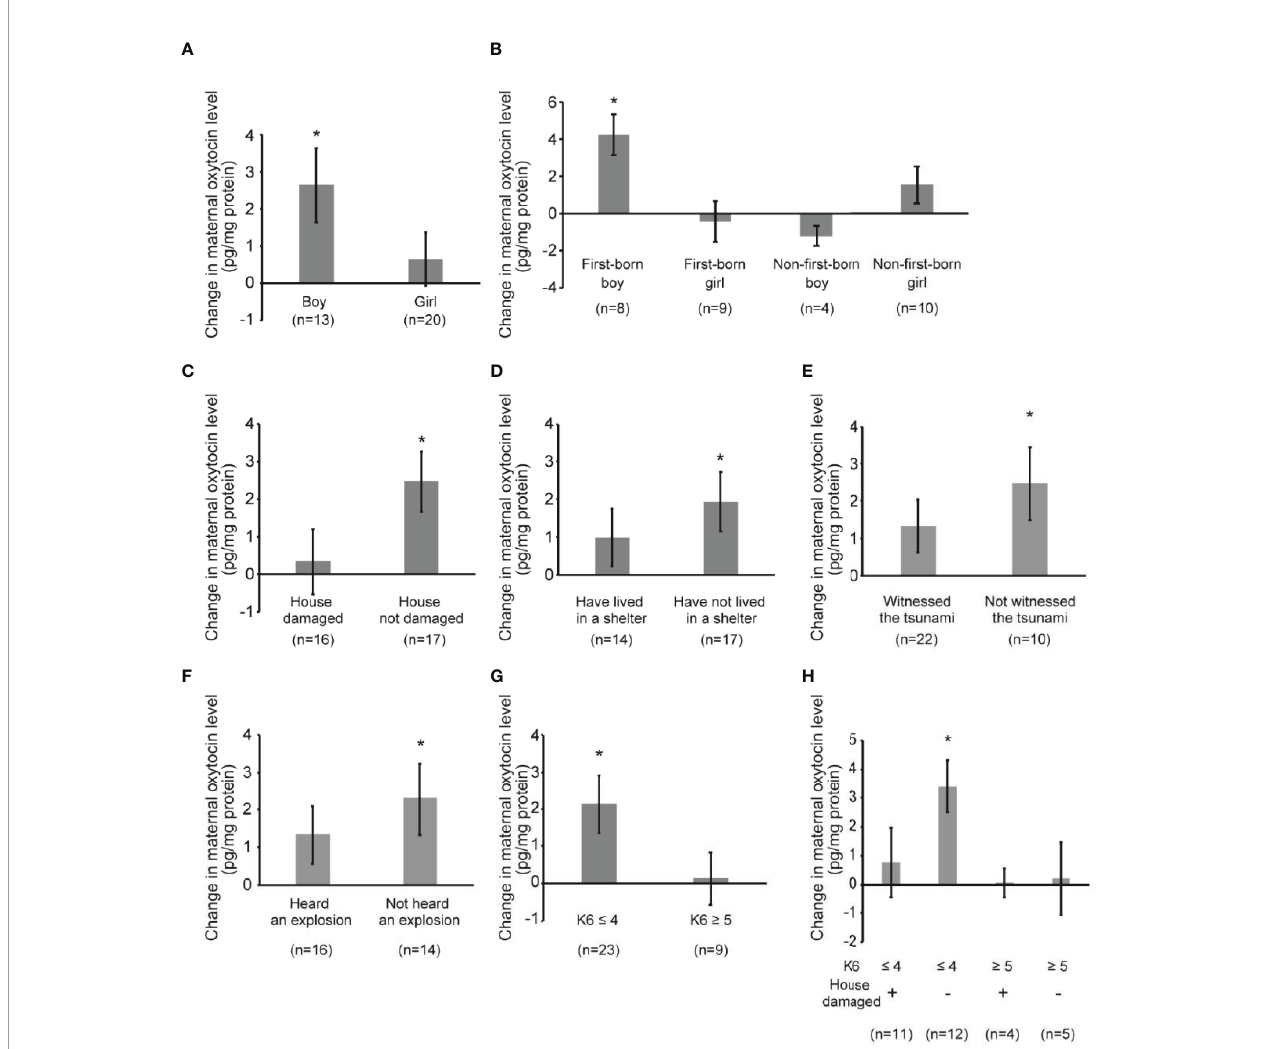
FIGURE 3 | Maternal oxytocin response following playful mother – child interaction. (A) Change in maternal oxytocin levels by playful mother – child interaction by stratifying by child sex. * P < 0.05. (B) Change in maternal oxytocin levels by playful mother – child interaction by stratifying according to sex of the child as well as the birth order of the child. * P < 0.05. (C) Change in maternal oxytocin levels by playful mother – child interaction by stratifying by the presence of damage to the house by the earthquake. * P < 0.05. (D) Change in maternal oxytocin levels by playful mother – child interaction by stratifying by maternal experience of having lived in a shelter after the earthquake. * P < 0.05. (E) Change in maternal oxytocin levels by playful mother – child interaction by stratifying by the maternal experience of having witnessed tsunami after the earthquake. * P < 0.05. (F) Change in maternal oxytocin levels by playful mother – child interaction by stratifying by the maternal experience of having heard the explosion of multiple oil tanks after the earthquake. * P < 0.05. (G) Change in maternal oxytocin levels by playful mother – child interaction by stratifying by maternal psychological distress as assessed by K6 score ( ≤ 4 vs ≥ 5). * P < 0.05. (H) Change in maternal oxytocin levels by playful mother – child interaction by stratifying by maternal psychological distress as assessed by K6 score ( ≤ 4 vs ≥ 5) and the presence of damage to the house by the earthquake. * P < 0.05. All data and graph bars are expressed as the mean ± standard error. Saliva oxytocin values are in pg/mg